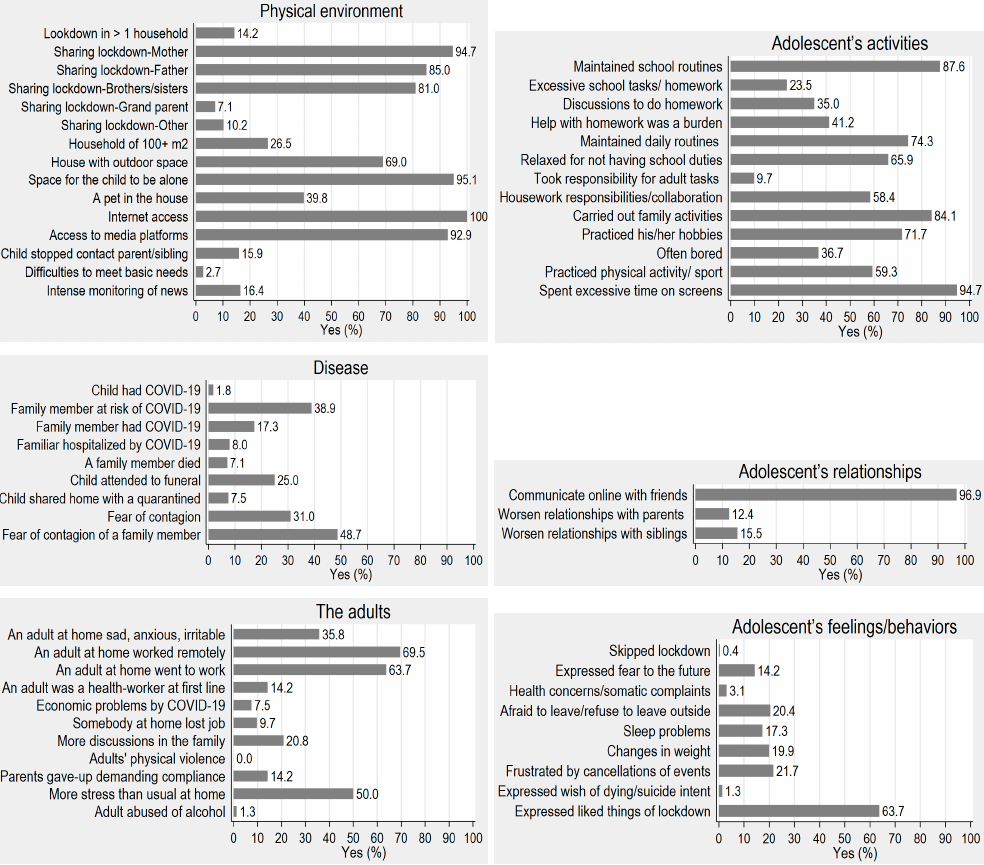
Figure 1 . Percentage of affirmative response for each group of COVID-19 questions ( N = 226). Figure 1. Percentage of a ffi rmative response for each group of COVID-19 questions ( N = 226). Table 1. Change in the Strengths and Di ffi culties Questionnaire (SDQ) psychological problems scores between Pre and Post COVID-19 ( N =